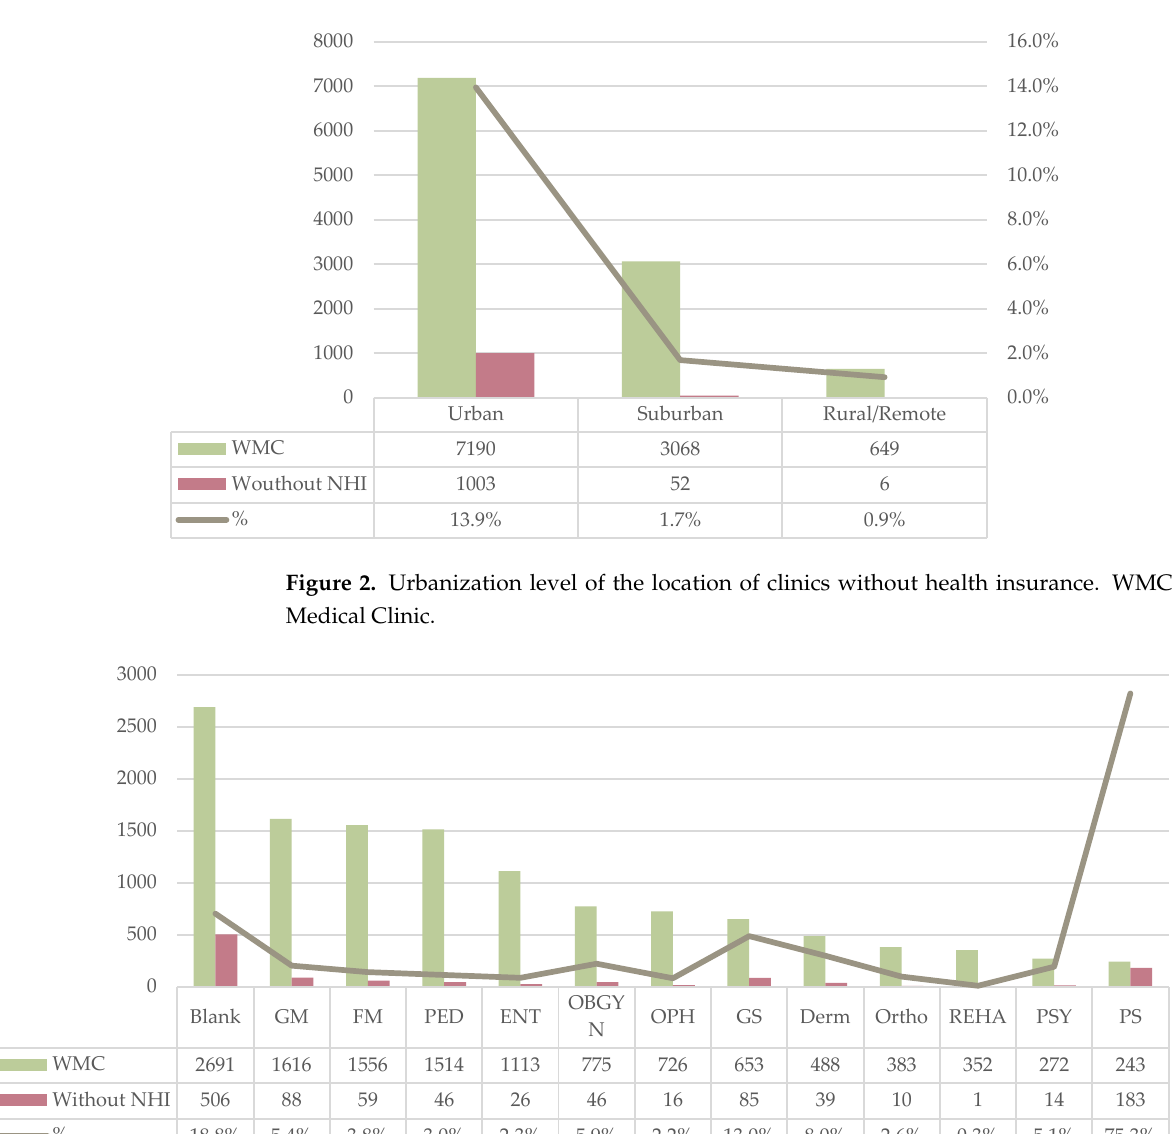
Figure 3. Medical specialties of clinics without health insurance. WMC: Western medical clinic; GM: general medicine; FM: family medicine; PED: pediatrics; ENT: otorhinolaryngology; OBGYN: obstetrics and gynecology; OPH: ophthalmology; GS: surgery; Derm: dermatology; Ortho: orthopedics; REHA: rehabilitation; PSY: psychiatry; PS: plastic surgery.